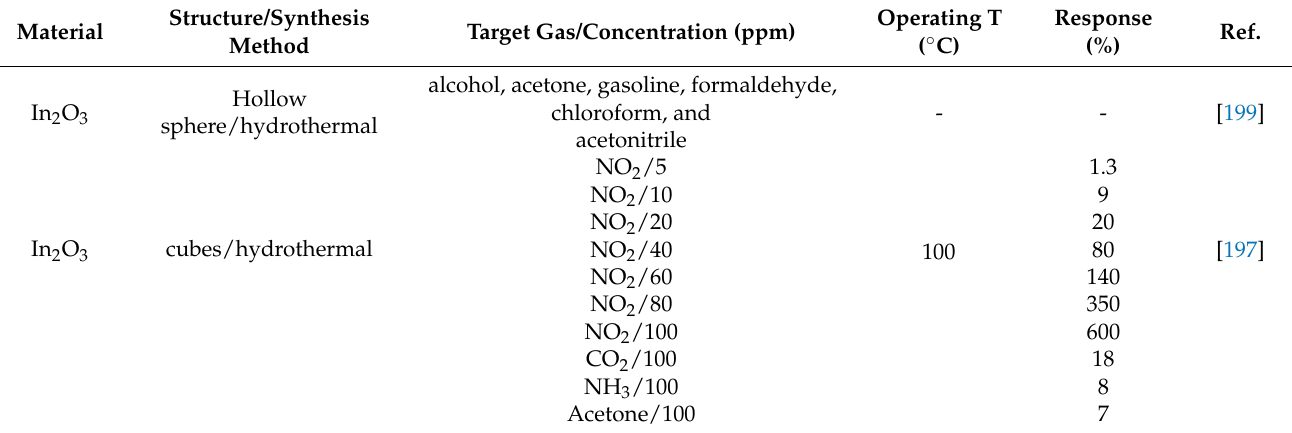
Figure 23. ( a ) The selectivity of indium oxide thin film sensor for 100 ppm of various gases at 100 ◦ C; ( b ) response/recovery time of indium oxide towards various concentrations of NO 2 gas. Reprinted from Ref. [197] with permission of Springer Science Business Media, LLC, 2018. Table 8. A summary of green synthesized In 2 O 3 nanoparticles as a gas